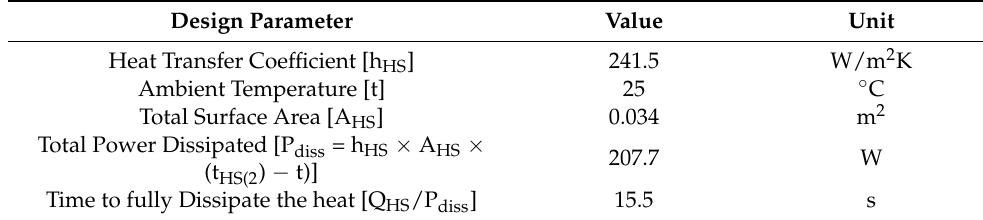
Table 3. Performance estimate for heat sink and fan. Table 2. Design parameters for selection heat sink and fan.